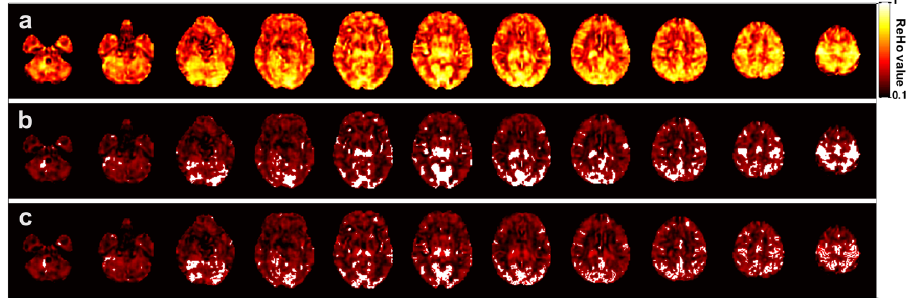
Figure 1. Demonstration of high-ReHo cluster (HRC) from a typical participant. ( a ) Whole-brain ReHo map of a typical participant. ( b ) High ReHo clusters (HRCs), constituted by the top 10% voxels among all voxels, are marked with white colour, and the background brain regions are dimmed in order to highlight the HRCs. ( c ) The shape of HRCs in ( b ) is further constrained by the shape of grey